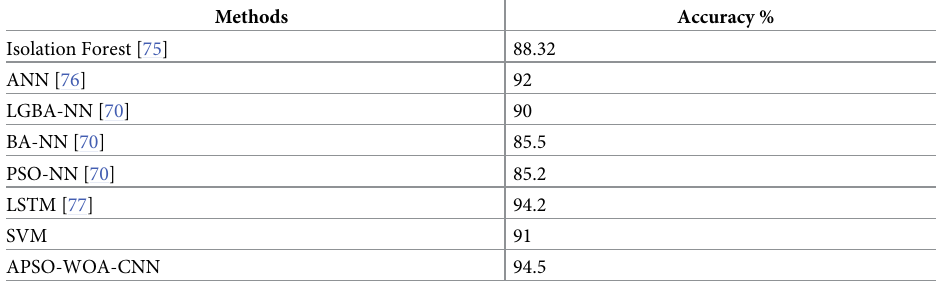
Table 7. Comparison of proposed model with other methods using same